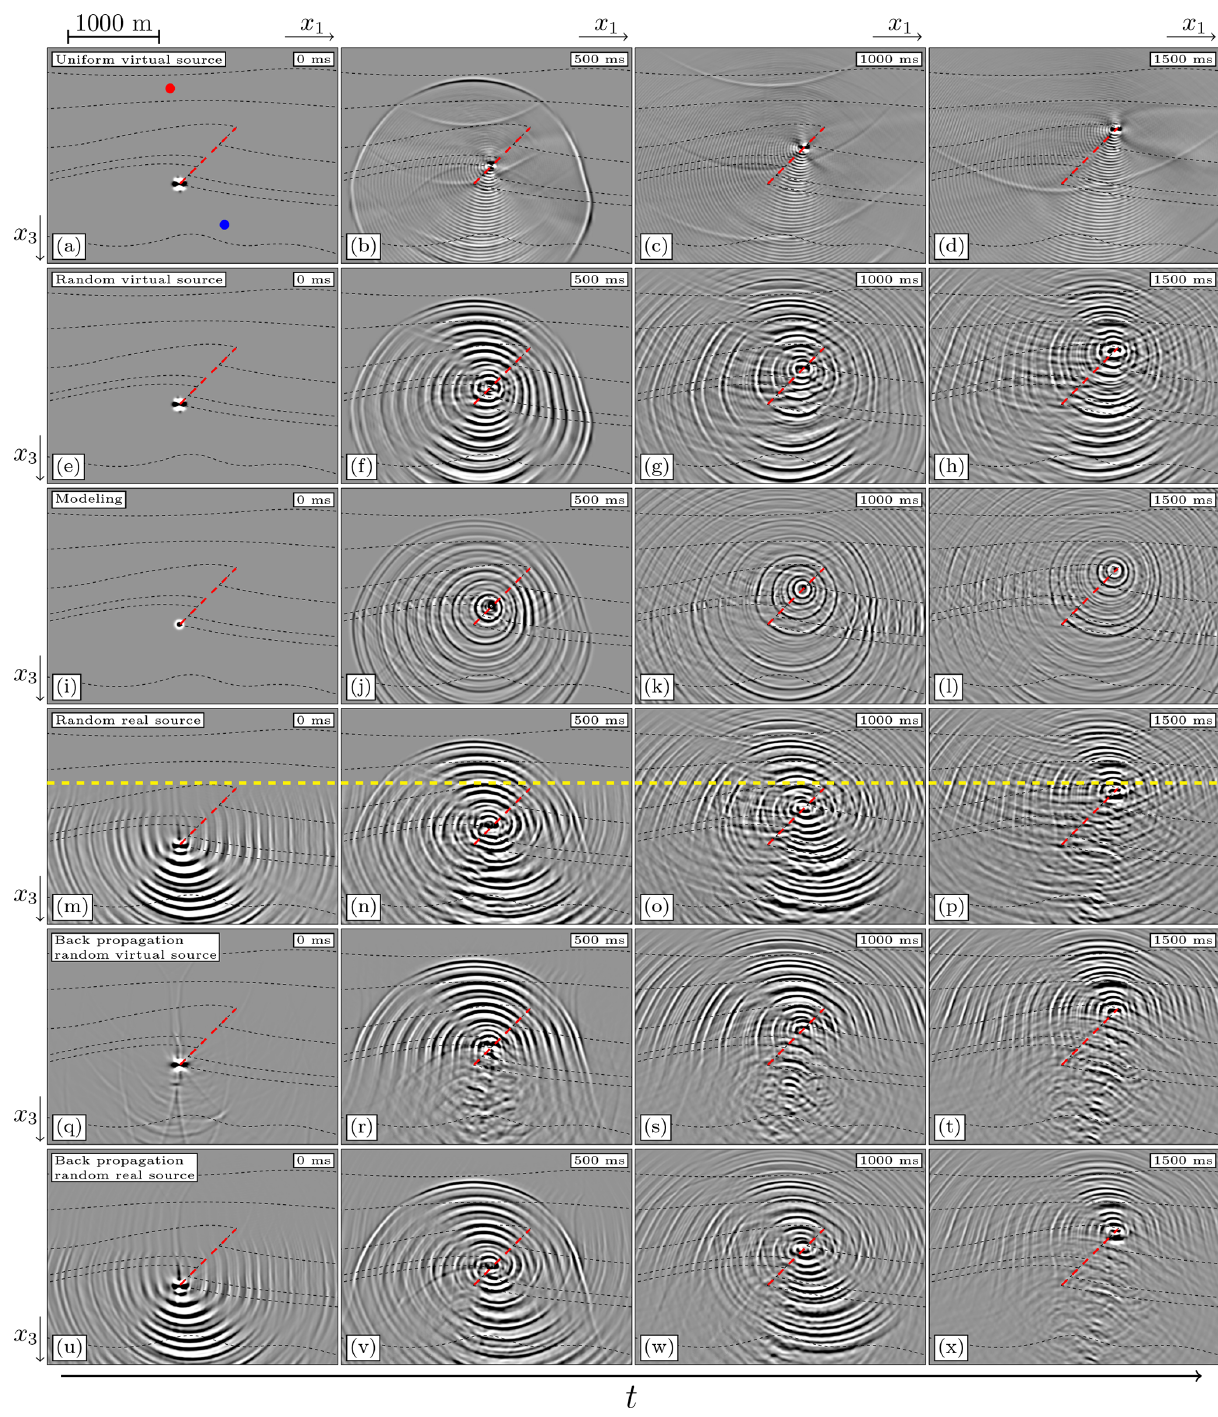
Figure 9. Snapshots of the wave field inside the white box in Fig. 5 for line sources. (a–d) Response in the subsurface, retrieved using Eq. (21) for virtual receivers and virtual double-couple sources inclined at 45 ◦ with a uniform amplitude. (e–h) Similar to (a–d) using random amplitudes for the source. (i–l) Directly modeled wave field using the exact model from Fig. 5a and b and monopole point sources with a random amplitude. (m–p) Similar to (e–h) using a superposition of double-couple sources with random amplitudes using Eq. (22). The yellow line indicates the border between the area below and above the shallowest source. (q–t) Similar to (e–h) , but instead of using the homogeneous Green’s function retrieval, the back propagation using Eq. (23) is used for each source position. (u–x) Similar to (m–p) , but instead of using the Green’s function retrieval, the back propagation using Eq. (23) is used. All wave fields have been convolved with a 30Hz Ricker wavelet. The red and blue dot indicate the locations of the traces in Fig. 10. The black dashed lines indicate the locations of geological layer